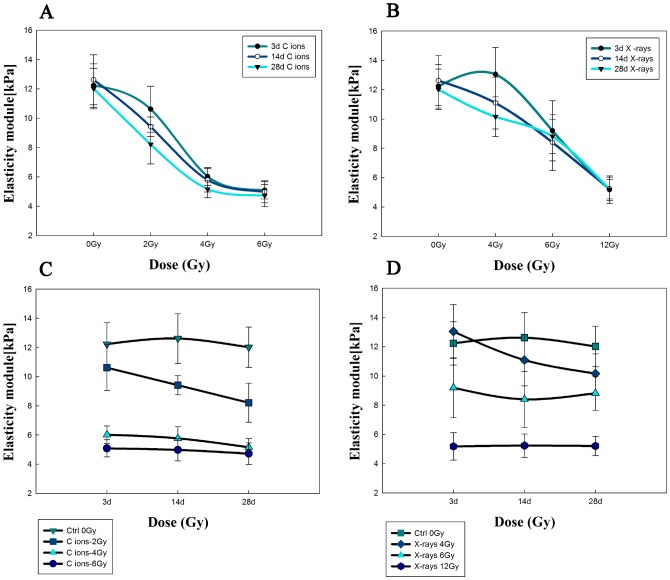
The change of elasticity modules of erythrocytes induced by C ions or X-rays radiation.And the groups displayed as a function of the dependent manner on dosage (A and B) and time (C and D). Error bars represent half-widths of the normal distributions fitted to the respective histograms.